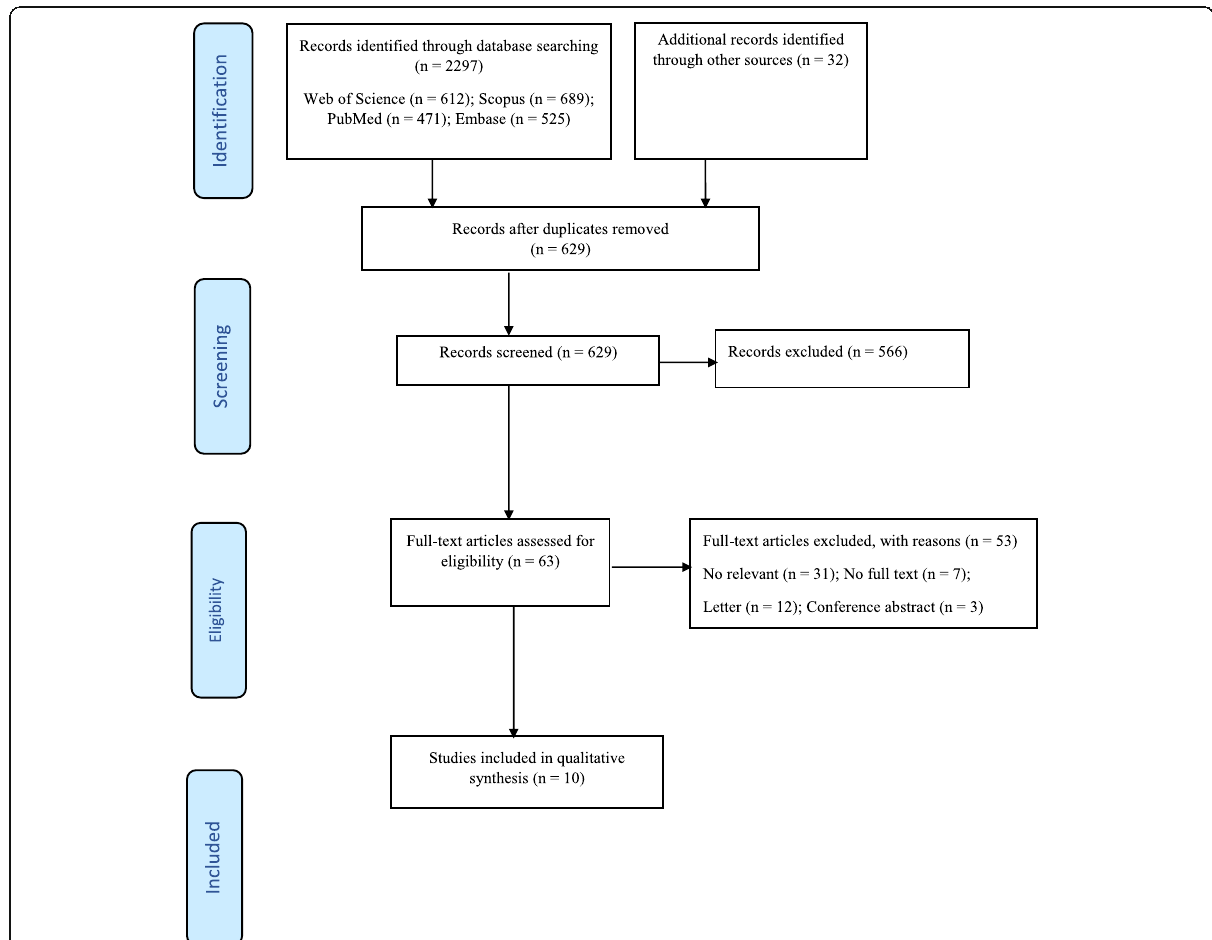
Fig. 1 PRISMA flow diagram showing the search, retrieval, and selection of potentially relevant